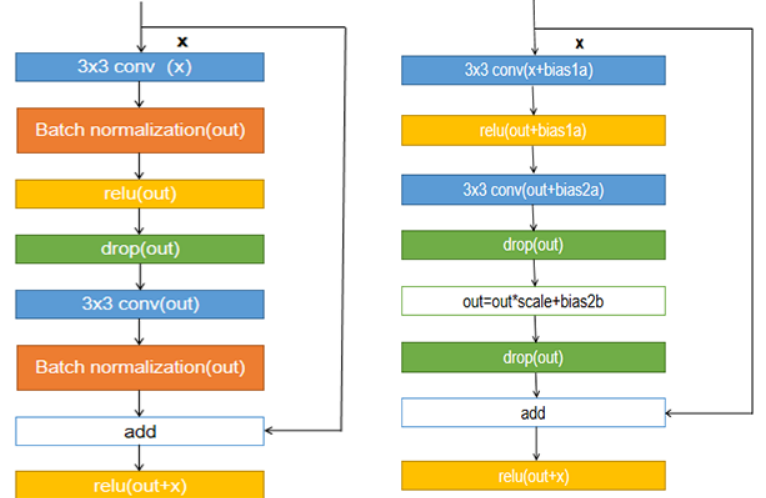
Figure 2. Resnet’s Basiclock structure on the left, and an improved Fixupblock structure on the